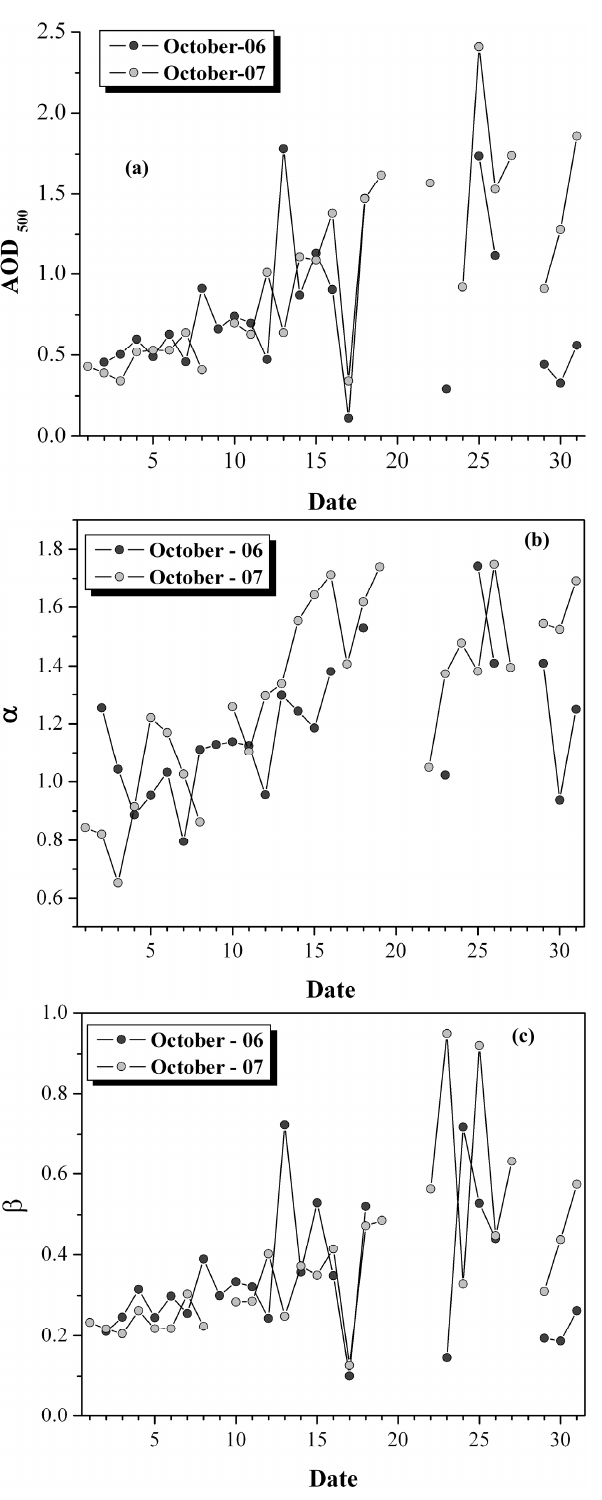
Fig. 4. Day-to-day variation of (a) MWR measured AOD 500 , (b) ˚Angstr¨om Exponent ( α) and (c) Turbidity parameter ( β) dur- ing October 2006 and 2007.